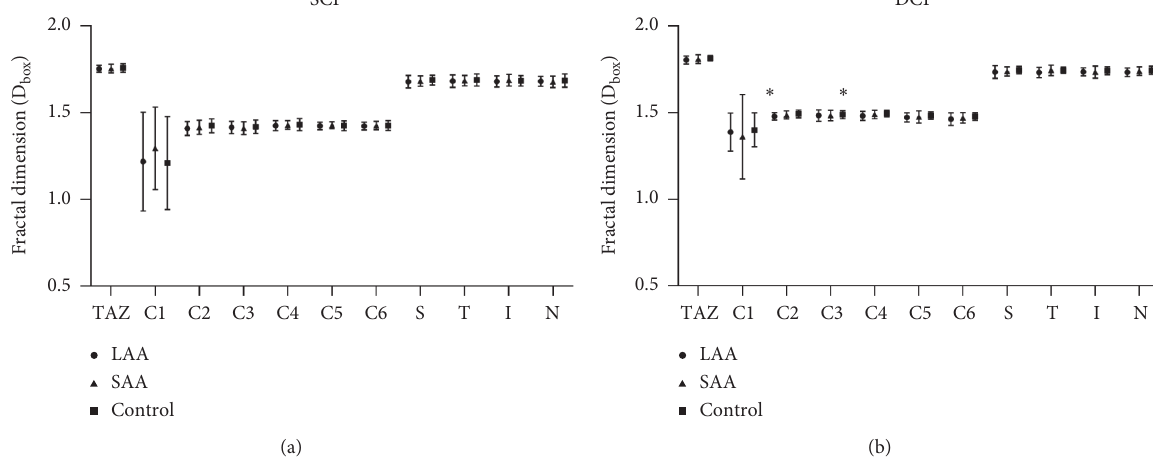
Figure 4: Comparisons of the microvascular D box among patients with large-artery atherosclerosis (LAA), small-vessel occlusion (SAA), and controls. Comparisons in (a) superficial capillary plexuses (SCP) and (b) deep capillary plexuses (DCP). A significant reduction was seen in the deep layer of C2 and C4 region in LAA patients when compared to controls. ∗ P <